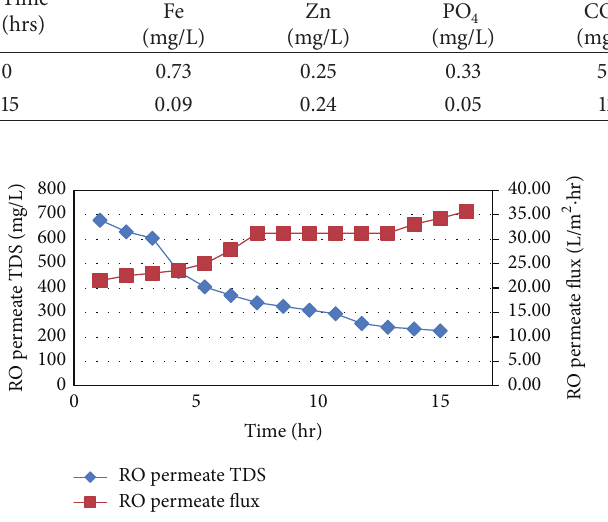
Figure 13: RO permeate TDS and flux as a function of time for FO/ RO continuous